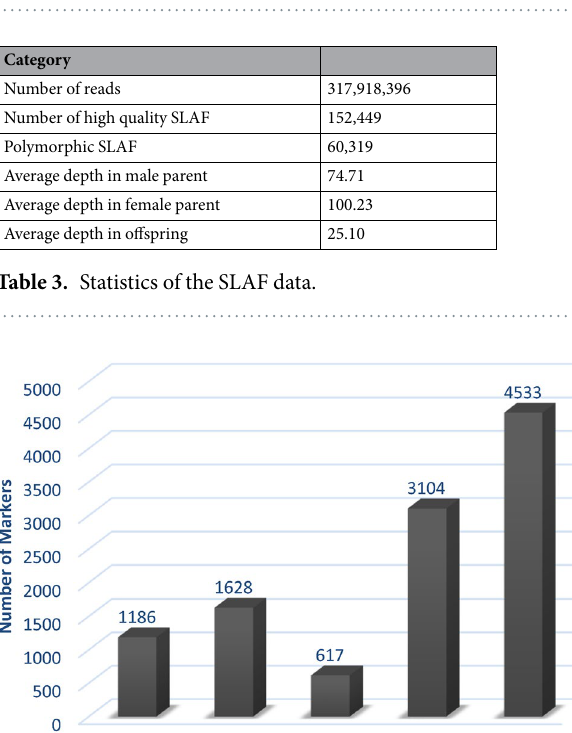
Table 2. Unigenes of transcriptome blast with genomic scaffolds/contigs.